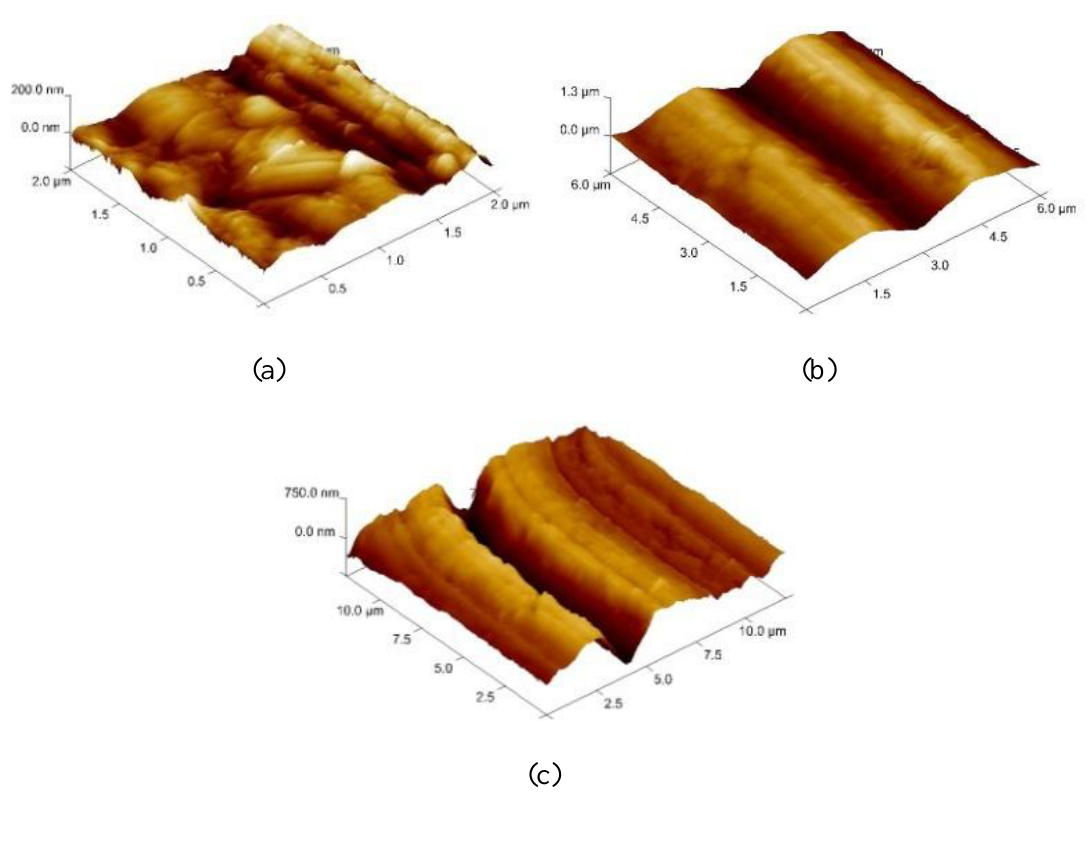
Figure 4. Three dimensional Height images for different scan sizes for K68 uncoated carbide inserts of (a) 2 μm; (b) 6 μm and (c) 12